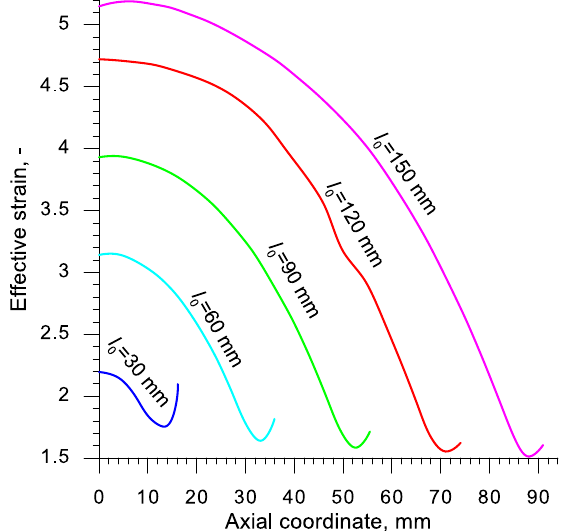
Figure 11. Numerically calculated distribution of effective strain in the axis of the sample, heated to 1150 °C and subjected to rotational compression on the path 315 mm; axial ordinate 0 describes the location of the plane of symmetry.